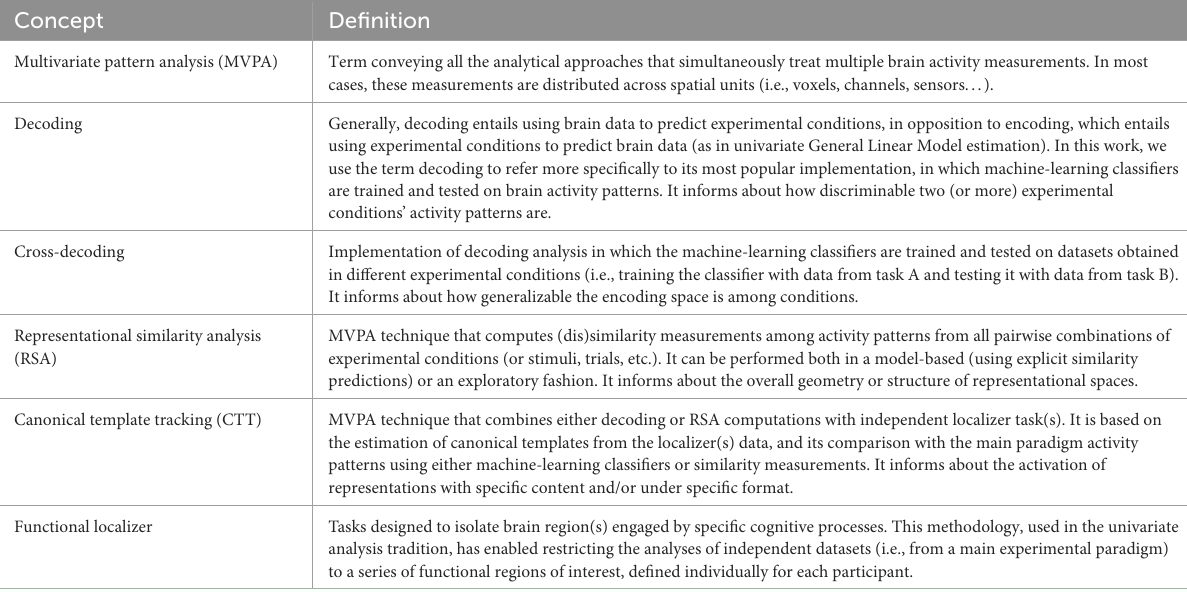
TABLE 1 Glossary with definitions of the main analysis labels used in the